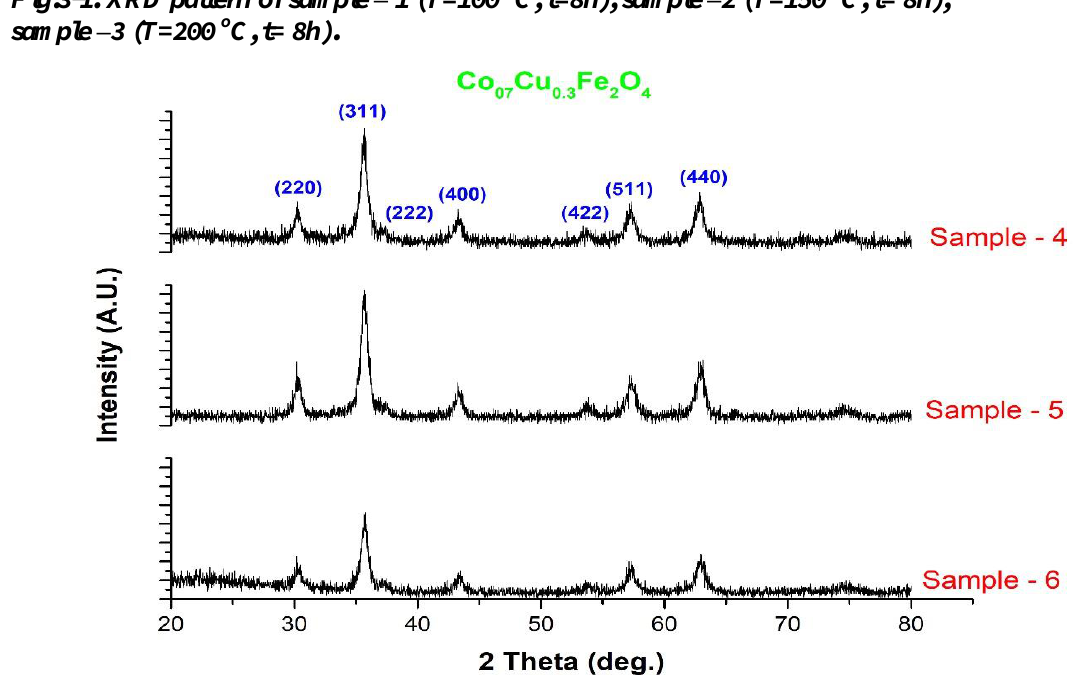
Fig.3-II: XRD pattern of sample – 4 (T=100 o C, t=8h), sample – 5 (T=150 o C, t= 8h), sample – 6 (T=200 o C, t=